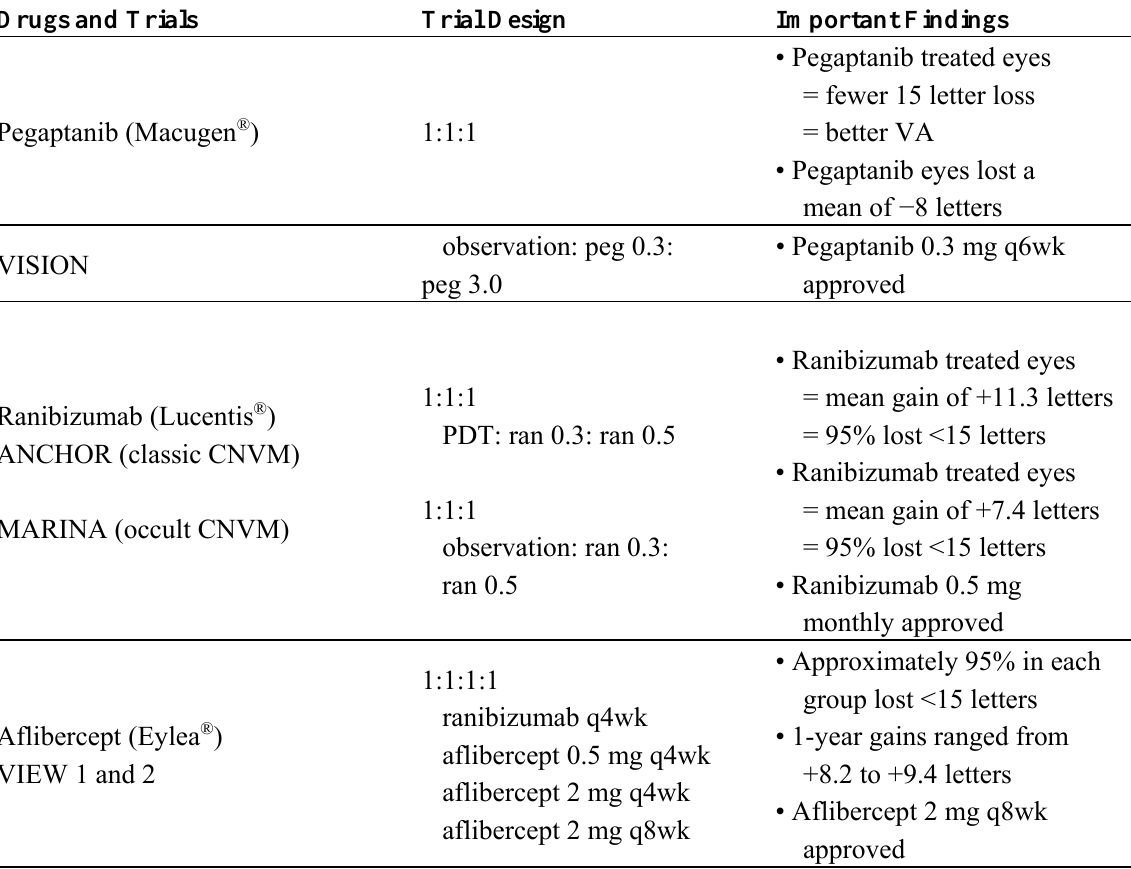
Table 1. Phase III registration trials supporting the use of anti-VEGF drugs in eyes with neovascular age-related macular degeneration are listed. Important design characteristics and top-end results are included. peg = pegaptanib; VA = visual acuity; CNVM = choroidal neovascularization; PDT = photodynamic therapy; wk =